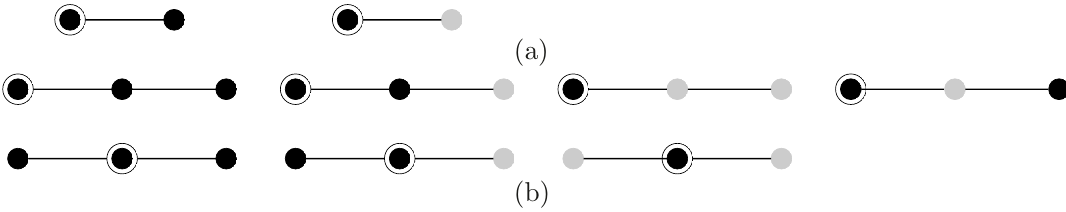
Figure 3 . Rooted trees corresponding to the Wilson loop in the large N , we see that inserting the operator selects from figure 1 trees with the same color as the operator that we are inserting, trees containing two different colors arise from interaction terms in (2.10). ( a ) Terms corresponding to V ( l, n 1 − k 1 ) V ( k 1 ). ( b ) Trees corresponding to V ( l, n 1 − k 1 ) V ( k 1 , n 2 − k 2 ) V ( k 2 ) and V ( l, n 1 − k 1 , n 2 − k 2 ) V ( k 1 ) V ( k 2